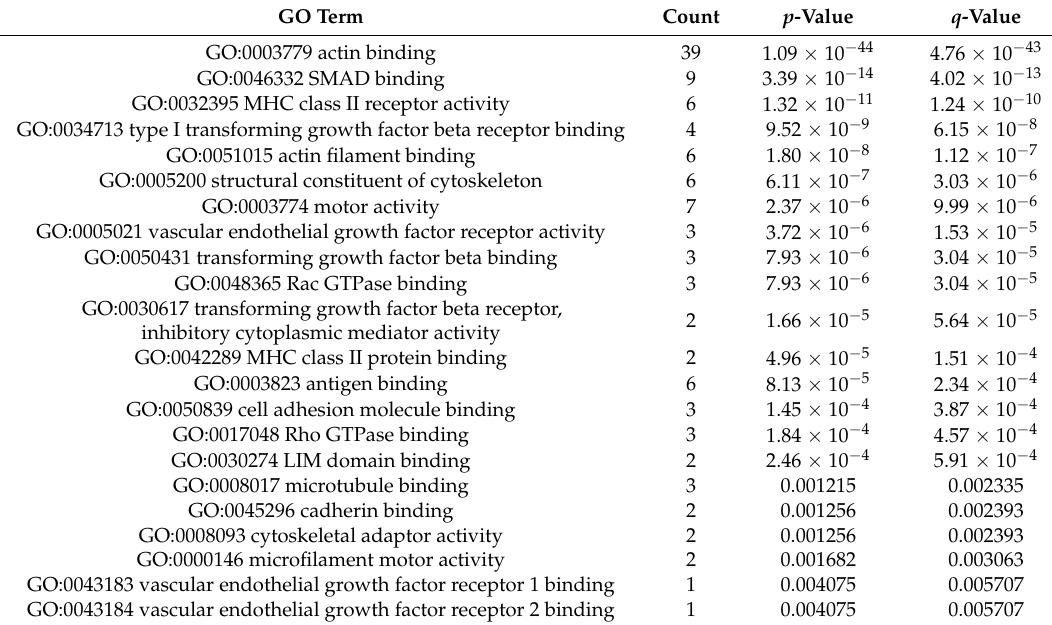
Table 3. GO term analysis of the downregulated